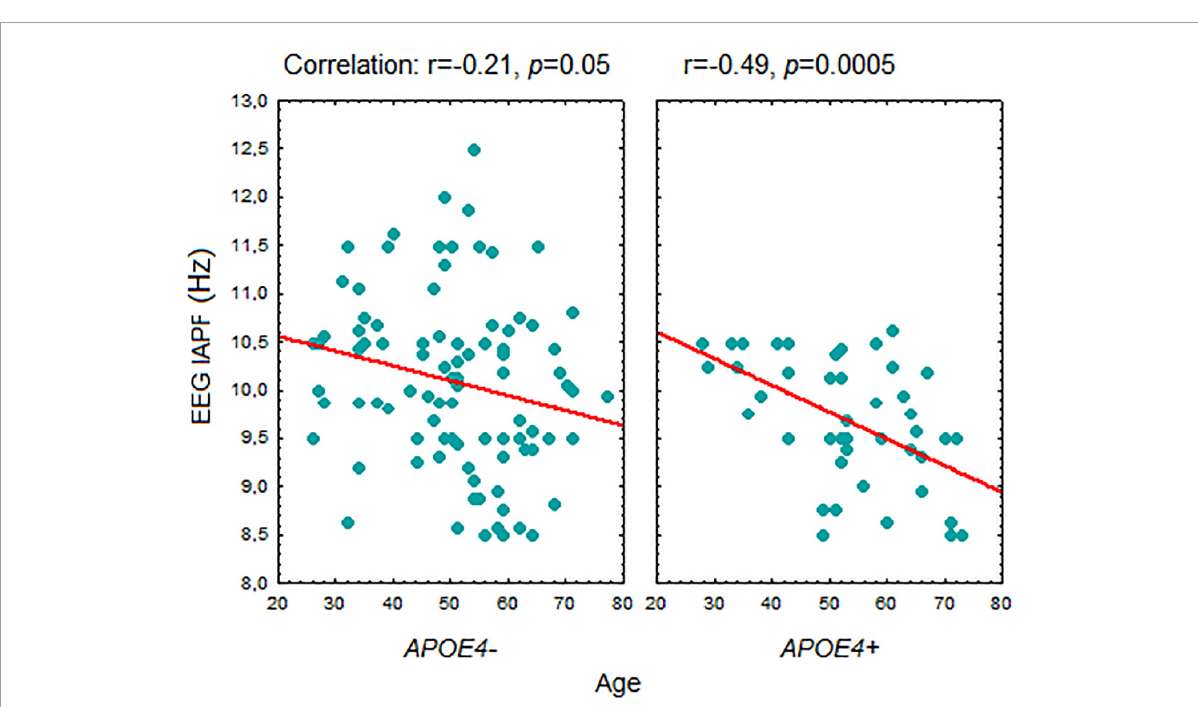
FIGURE4 Correlation between age and EEG individual alpha peak frequency in APOE4+ and APOE4– healthy subjects. Abbreviations are the same as in Figure 1